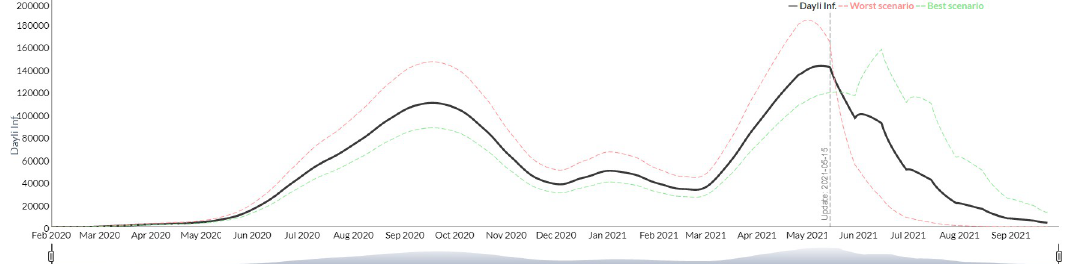
Fig 4. Simulation of the evolution of the new daily infected from July 2020 to September 2021 with oscilating R0 (Argentina).